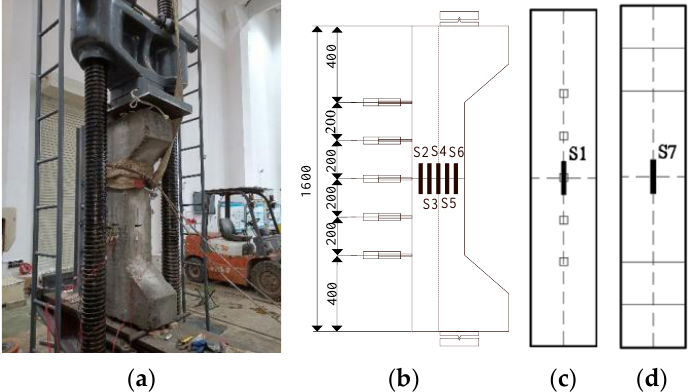
Figure 6. Specimen loading and measurement point arrangement diagram. ( a ) Loading map; ( b ) Side; ( c ) Pulled side; ( d ) Pressurized side.